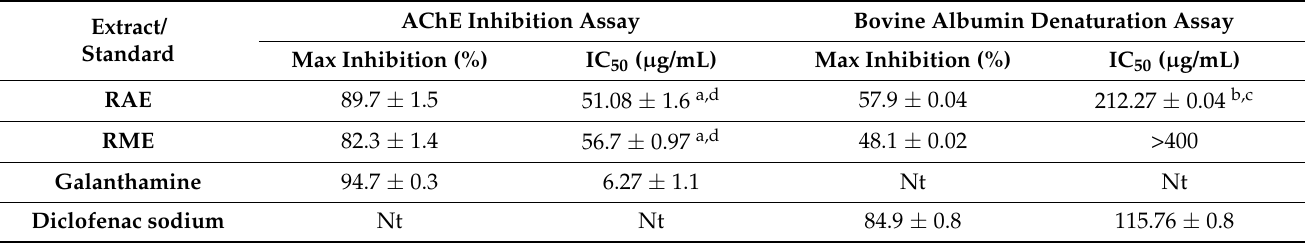
Table 3. Inhibitory effect of R. tuberculata extracts on acetyl-cholinesterase and bovine albumin denaturation